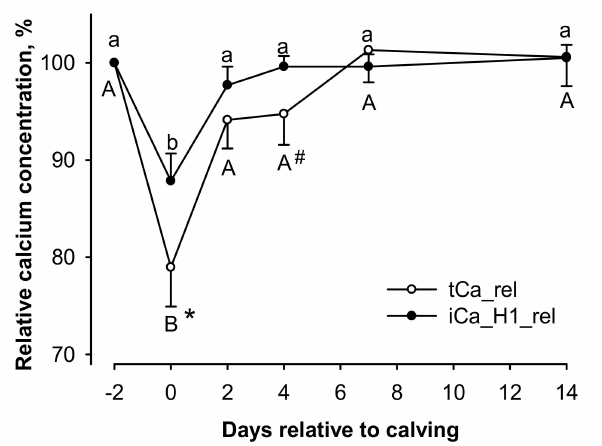
Figure 2. Influence of days in milk on total serum calcium (tCa_rel) and ionized calcium measured from heparinized vacutainer (iCa_H1_rel) relative to the prepartum values at day − 2 (100%). Relative values were affected by time ( p < 0.01) with two-way interaction of time × measurement method ( p < 0.05). A,B different capital letters and a,b small letters indicate differences for tCa_rel and iCa_H1_rel, respectively ( p < 0.05, each). #,* hash key and asterisk indicate a trend for difference ( p < 0.1) and difference to the corresponding value of iCa_H1_rel ( p < 0.05),